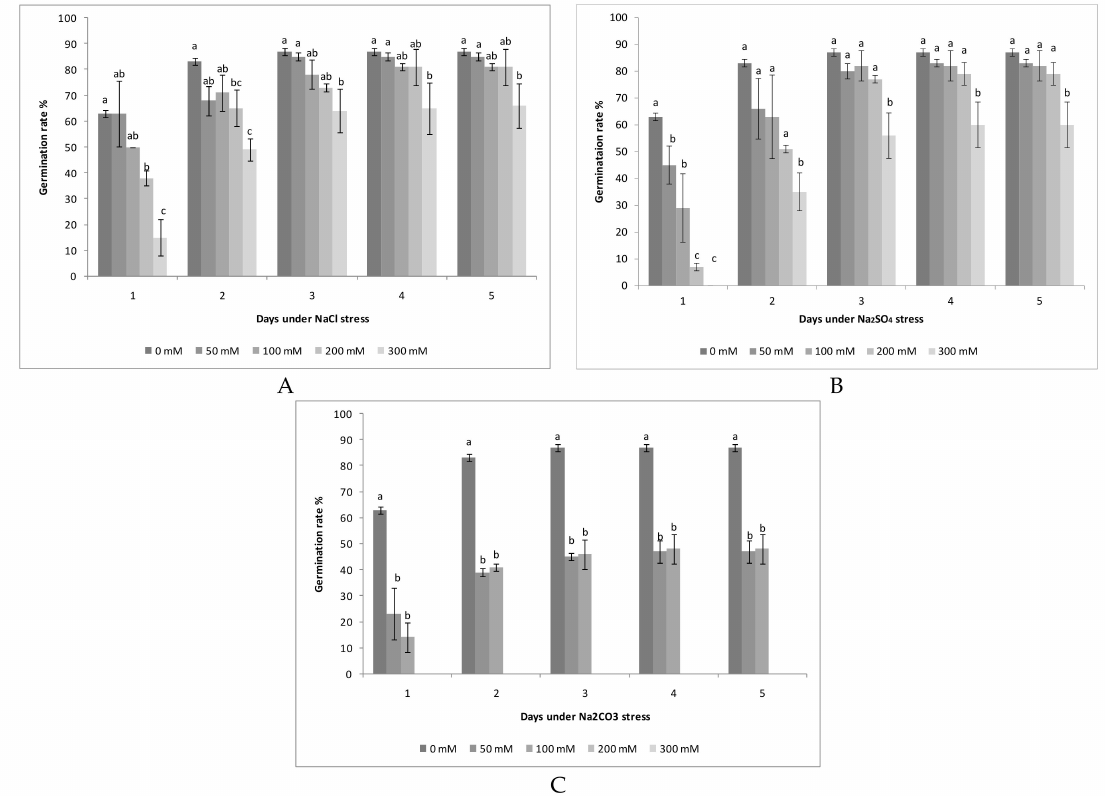
Figure 2. Seed germination rate of Puno cultivar under NaCl ( A ), Na 2 SO 4 ( B ) and Na 2 CO 3 ( C ) stresses. Di ff erent letter means significant di ff erences, according to Tukey test. Error bars indicate mean ±